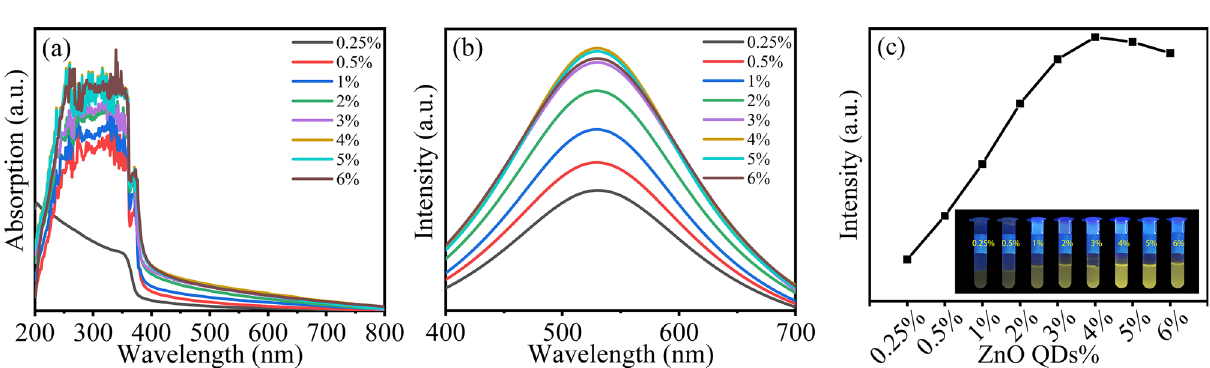
Figure 4. ( a ) The UV–vis spectra of M-ZnO QDs solutions with different concentrations. ( b ) The fluorescence spectra of M-ZnO QDs solutions with different concentrations. ( c ) The trend of fluorescence intensity of M-ZnO QDs solutions with different concentrations (the inset is the fluorescence effect of M-ZnO QDs solutions with different